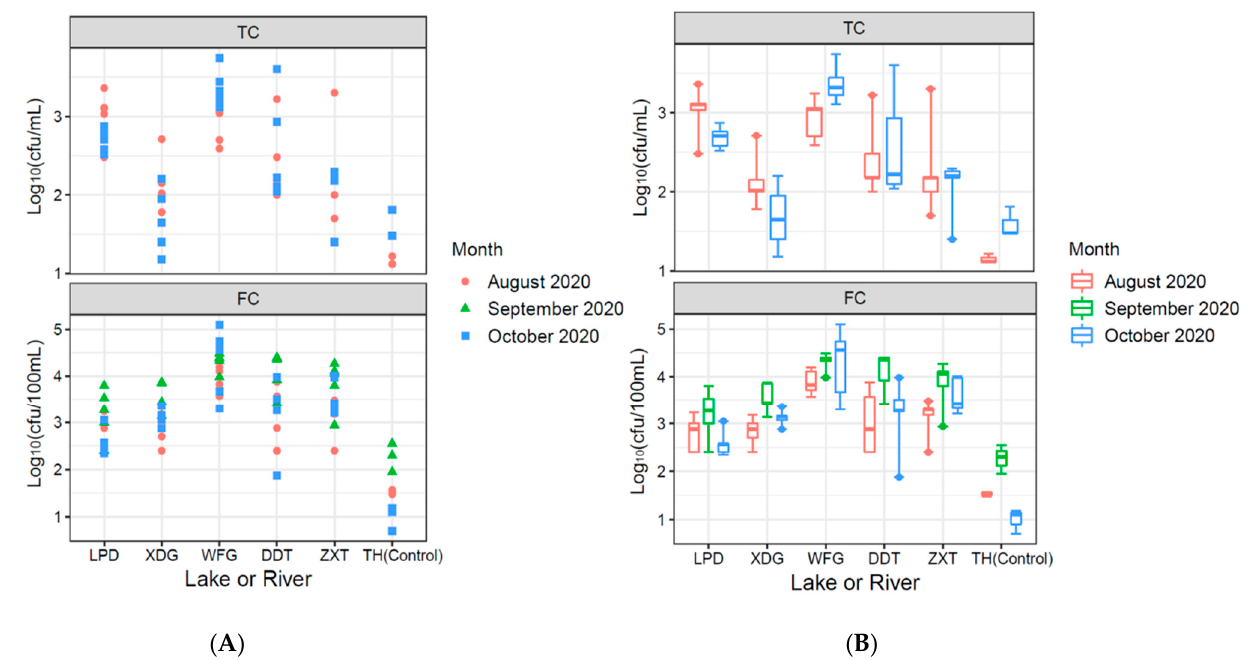
Figure 5. The variation in the total coliform (TC) and fecal coliform (FC) values observed in different sampling locations and months. The individual value for each parameter ( A ) and boxplots ( B ) with minimum and maximum values (whiskers), median value (line within each box), and quartile interval (box) are shown.